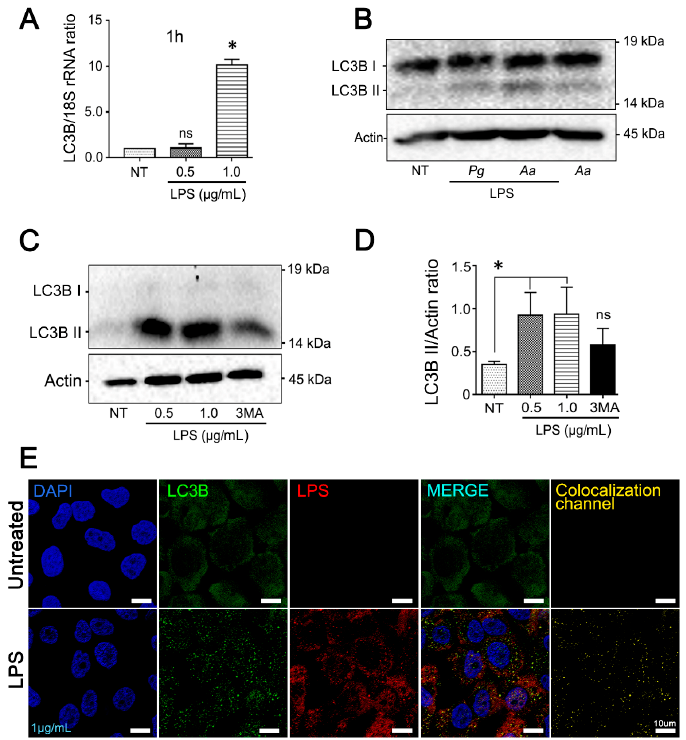
Figure 5. Increased expression of autophagy markers in JEKs stimulated with purified LPS from A. actinomycetemcomitans . OKF6/TERT-2 cells were incubated with 0.5 or 1 µg/mL of purified LPS from A.a . ( A ) Quantitative real-time PCR of LC3B transcripts abundance normalized to 18S rRNA levels after 1 h of LPS stimulation. ( B ) Immunoblotting of protein extracts from OKF6/TERT-2 cells stimulated for 3 h with LPS or whole A.a bacteria incubated with antibodies specific for the autophagy-related protein LC3B. LPS purified from Porphyromonas gingivalis ( Pg ) was used as positive control. β -actin protein was employed as a loading control. The results are shown as the average of the actin normalized data from three independent experiments. ( C ) Conversion of LC3B-I to LC3B-II in LPS-stimulated cells. JEKs were pretreated with 3-MA (3 mM) or mock-treated for 3 h before stimulation with LPS. ( D ) Densitometric quantitation of actin-normalized protein bands is indicated on the right. 3-MA used as control. ( E ) Confocal image of JEKs stimulated with 1 µg/mL of LPS. Blue: DNA rich structures stained with DAPI; green: LC3B protein labeled with anti-LC3B antibody; red: LPS purified from A.a labeled with anti-LPS antibody; merge: digital overlap of blue, green and red channels; yellow: colocalized voxels from merged file. Note the puncta profile of LC3B-labeling in LPS-stimulated cells. Scale bar 10 µm. * p < 0.05.